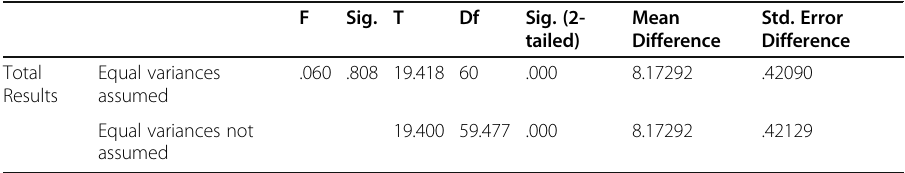
Table 3 Independent Samples T test of Control and Experimental Groups